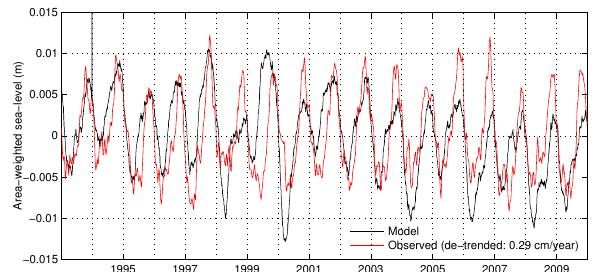
Fig. A1. Time series of area-weighted global mean sea level from the model (black) and observations (red), each relative to their own Fig. 18. Time series of area-weighted global-mean sea-level from the model (black) and observations (red), time means. The linear trend has been removed from the obser- eachrelativetotheirowntime-means. Thelineartrendhasbeenremovedfromtheobservationsthatarebased ongriddedsea-levelanomalymapsfromAviso. vations that are based on gridded sea level anomaly maps from